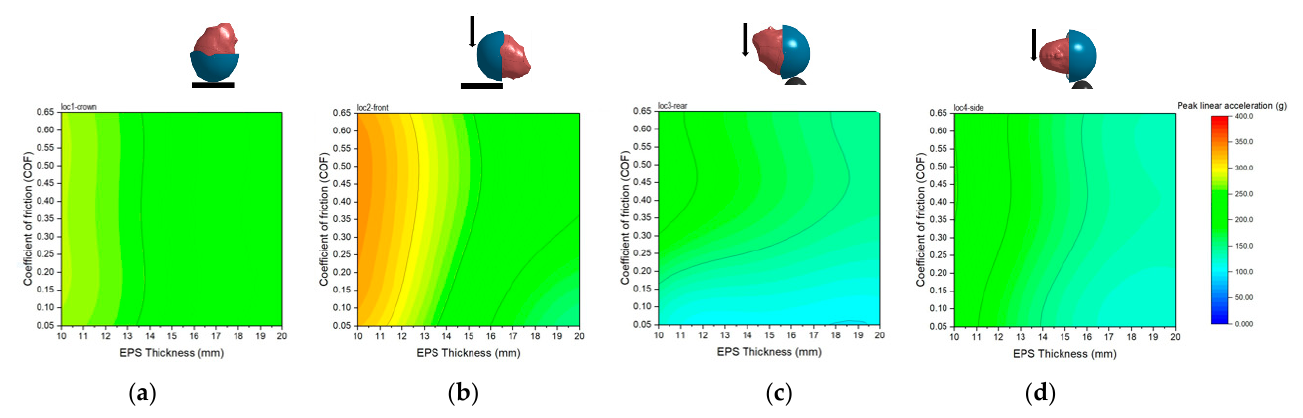
Figure 14. Relationship between helmet parameters and the peak linear acceleration predicted by the ROM with the DOT drop test at ( a ) crown, ( b ) front, ( c ) rear, and ( d ) side impact locations.